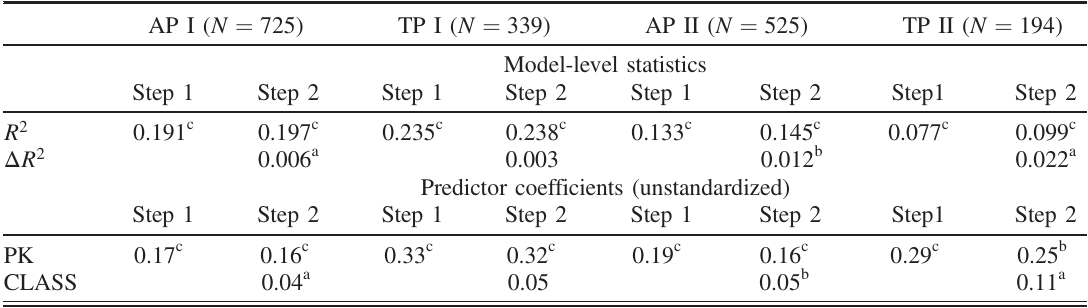
TABLE III. Regression-model summaries predicting exam scores from prior knowledge measures and overall CLASS scores. The notations on the table are as follows: Fall Active Physics (AP I); Fall Traditional Physics (TP I); Spring Active Physics (AP II); Spring Traditional Physics (TP II); number of observations ( N ); change in R 2 between step 1 and step 2 ( Δ R 2 ); prior knowledge (PK) (FCI in AP I and TP I, BEMA in AP II and TP II). Prior knowledge alone was entered in step 1 of each model, and then overall CLASS was added in step